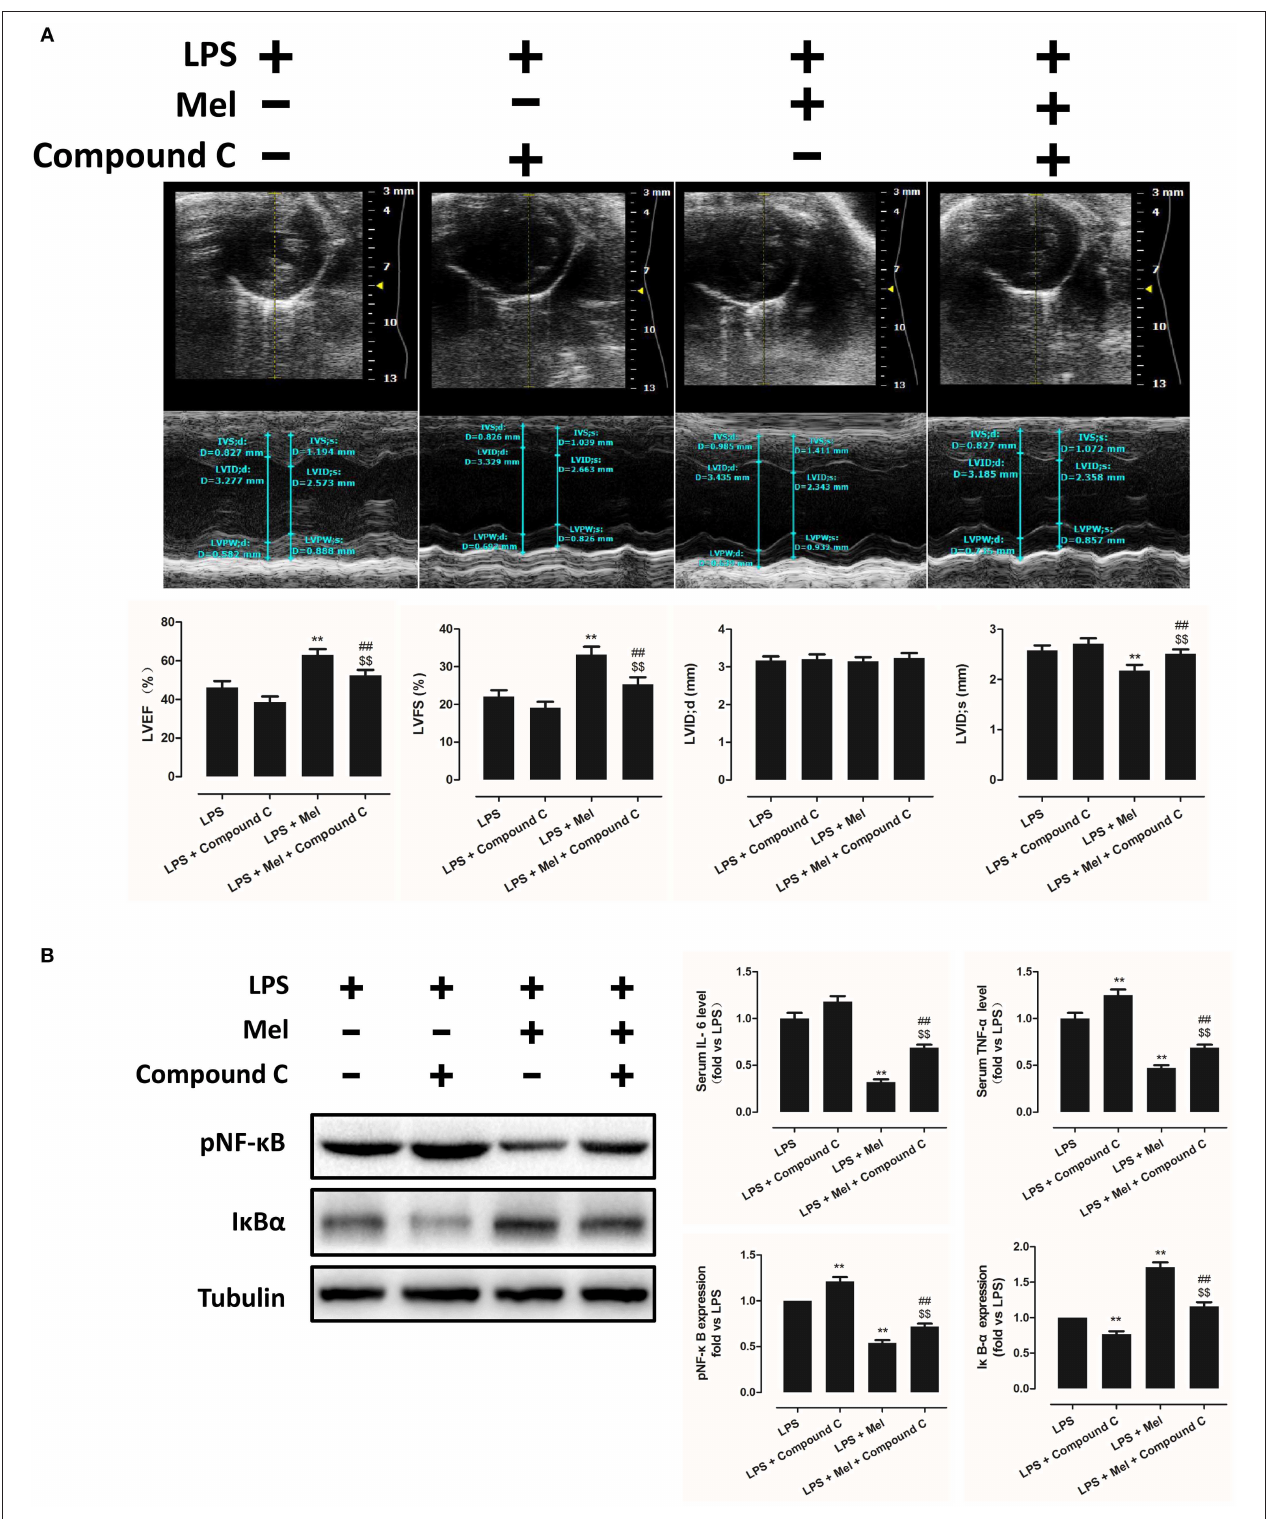
FIGURE 4 | Compound C treatment exacerbated LPS-induced injury and impaired melatonin-induced cardiac protection. (A) Representative M-mode echocardiograms from mice in each group and quantitative analysis of mice LVEF, FS, LVID; d, LVID; s. (B) Representative bands of pNF- κ B and I κ B α , and quantitative analysis of pNF- κ B, I κ B α expressions and serum IL-6, TNF- α levels. n = 6. ** P < 0.05 vs. the LPS group, ## P < 0.05 vs. the LPS + Compound C group, $$ P < 0.05 vs. the LPS + melatonin group. Mel, melatonin.